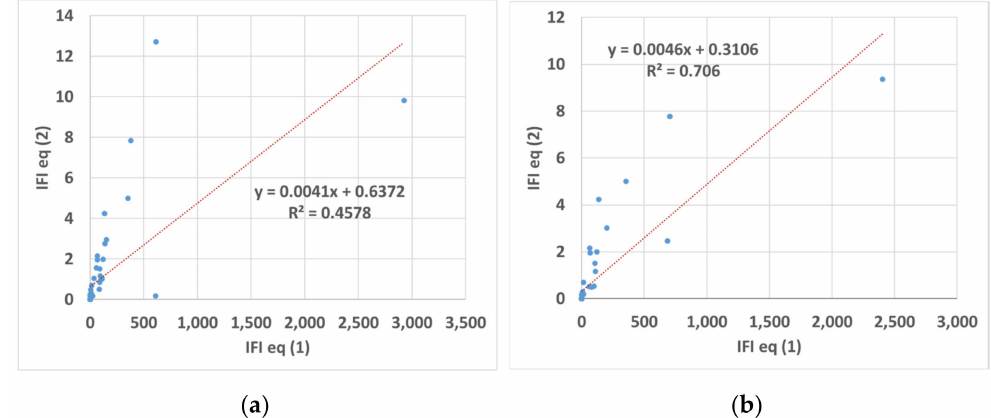
Figure 5. Relationship between the IFI indices calculated with Equations (1) and (2) for the protected areas of the Natura 2000 Network in Extremadura: ( a ) SPAs and ( b ) SACs.